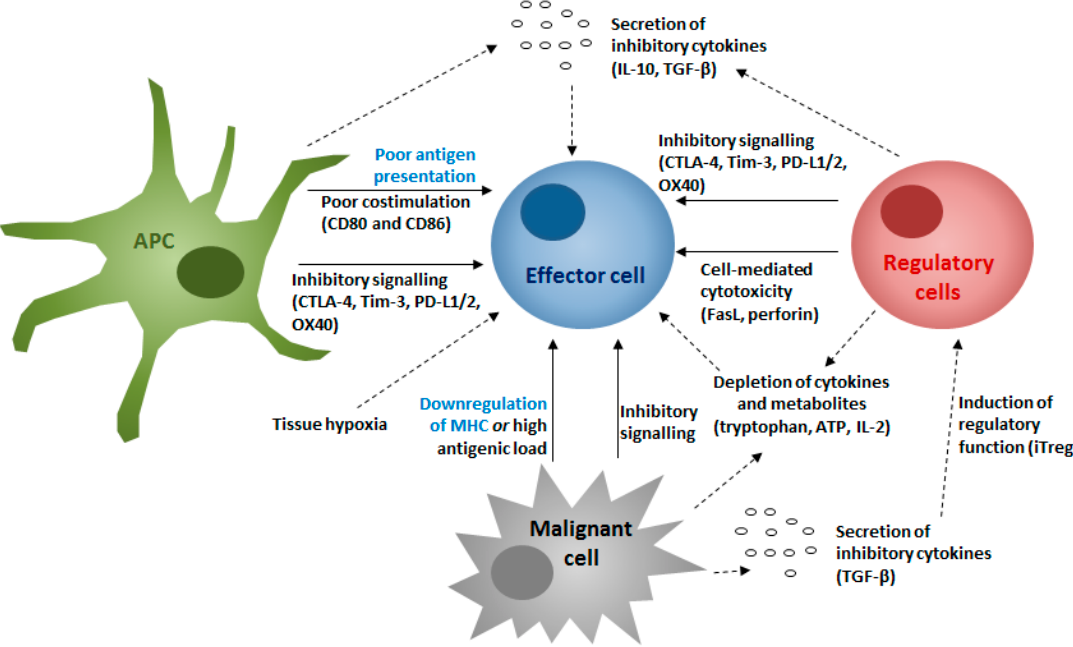
Figure 1. Mechanisms contributing to regulation of tumor clearance by e ff ector cells. APC, antigen presenting cell. In this context, an APC may be a macrophage, dendritic cell (or Langerhans cell) or B cell. Regulatory cells may represent various populations, including Treg, B cell regulatory populations, and myeloid-derived suppressor cells (MDSCs). E ff ector cell relates predominantly to CD8 + T cells, but may also include natural killer (NK), natural killer T (NKT), gamma-delta T, and cytotoxic CD4 + T cells. The above mechanisms contribute to e ff ector, particularly CD8 + , cell dysfunction and lead to a failure of tumor clearance. Those mechanisms highlighted in blue represent mechanisms of immune escape for the tumor. Examples of relevant mediators for each pathway are provided in brackets. Solid arrows represent mechanisms directed against specific cells through cell contact, whilst dashed arrows represent nonspecific mechanisms through remodeling of the tumor microenvironment (TME).